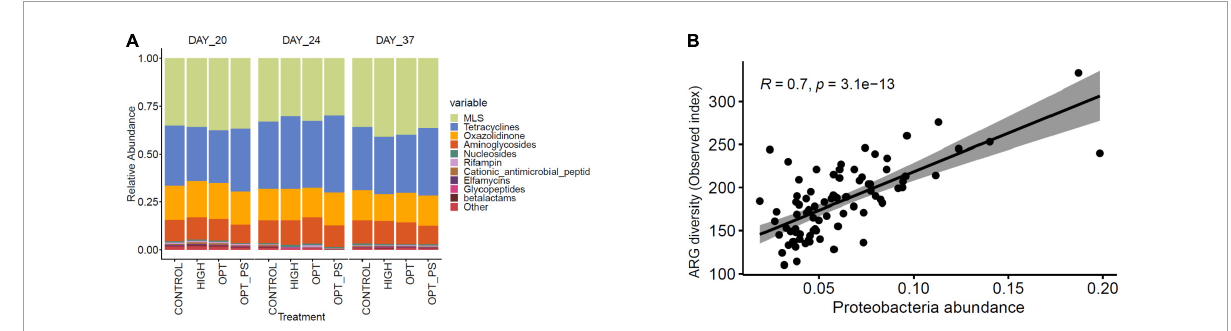
FIGURE6 (A) Relative abundances of the top 10 classes of ARGs in the cecum digesta of medicated and non-medicated broiler chickens at different time points. (B) Scatterplots showing a strong Spearman’s rho correlation coefficient (R) between the ARG resistome load and the abundance of Proteobacteria in broiler chicken cecum metagenome samples.